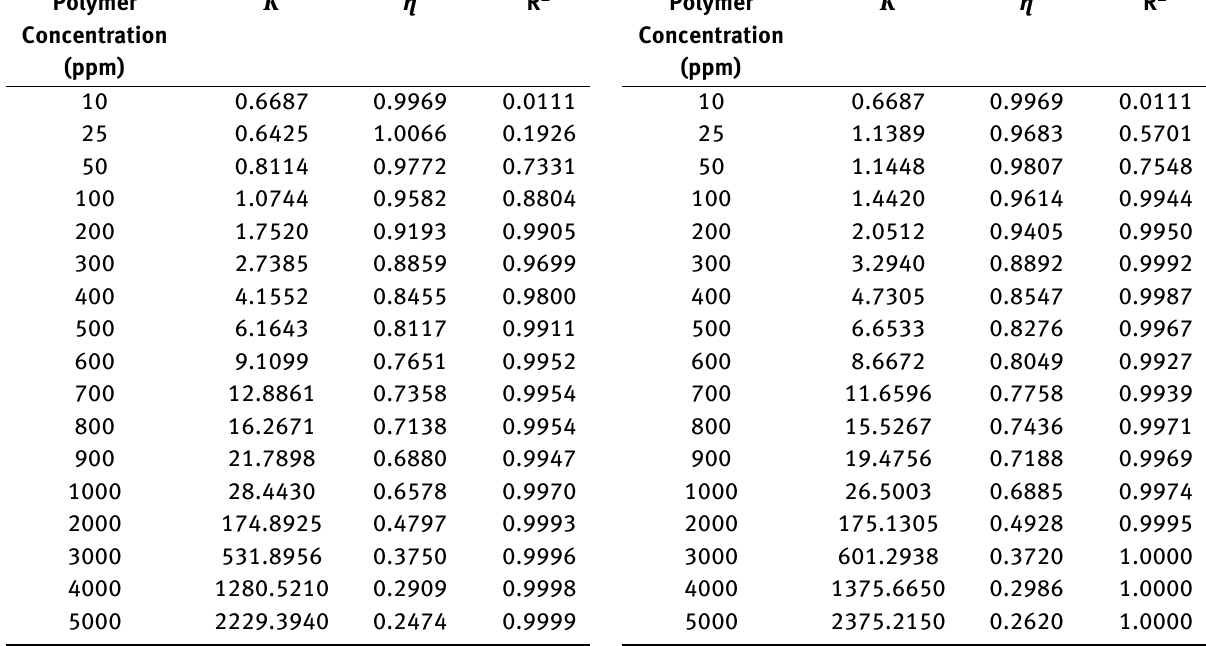
Table 6: Fit parameters to the Power Law Model for 50 ∘ C/20,000 ppm NaCl Polymer